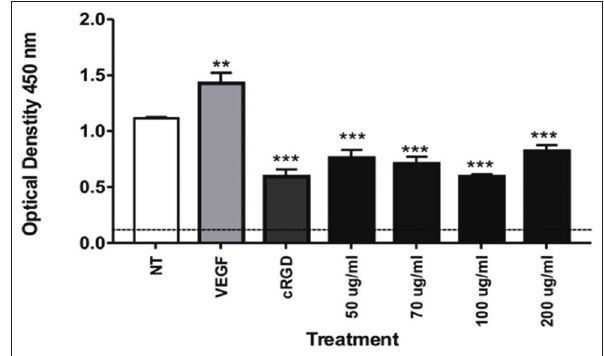
Figure-2: Ocimum sanctum ethanolic extract significantly decreases the expression of integrin α v β 3 in A549 cells. A549 cell lysates were analyzed using the human ITG α v β 3 enzyme-linked immunosorbent assay kit. Statistical analysis was performed by one-way analysis of variance followed by Tukey’s post hoc test as appropriate (****p<0.05=significant).